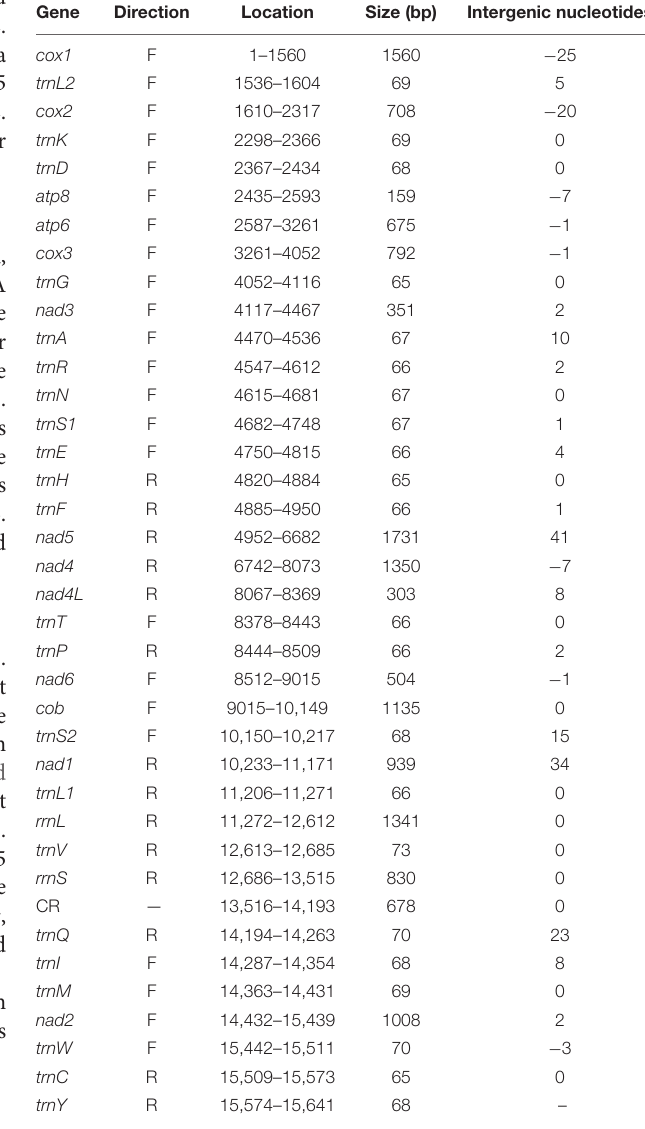
TABLE 2 | Summary of the P . bidens